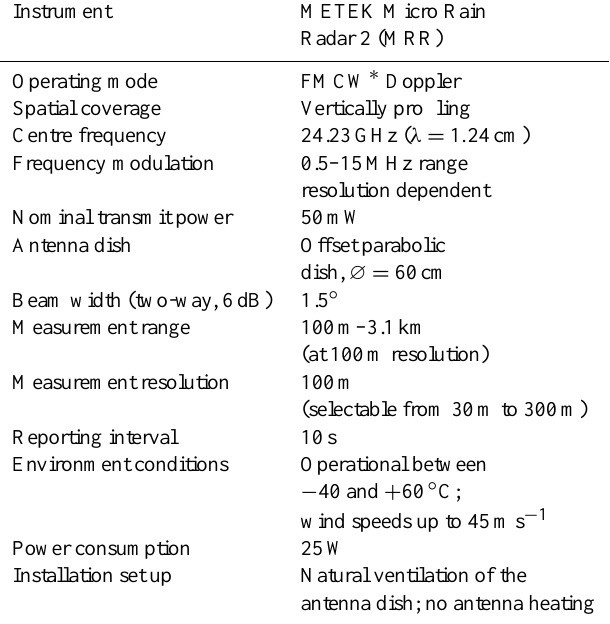
Table 3. Specifications of the HYDRANT infrared pyrometer.